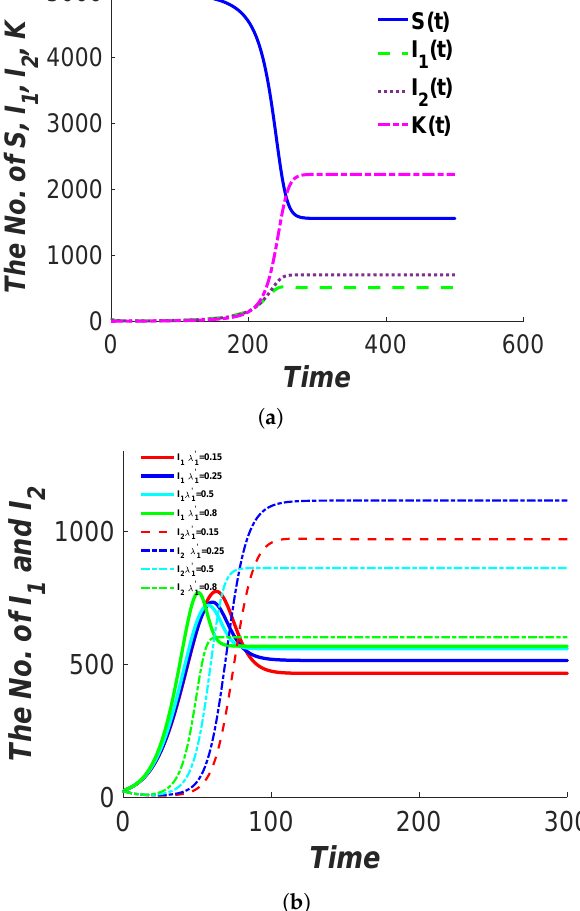
Figure 7. The evolution of the number of [ S ] , I 1 , I 2 over time for the co-infection case. ( a ) R 0 < 1 = 0.7, λ (cid:48) = 0.8, and restraint condition satisfied: λ 1 = 0.25, λ 2 = 0.15, γ 1 = 0.6, γ 2 = 0.4, λ (cid:48) 2 1 = 0.3, γ (cid:48) = 0.6, γ = 0.1. ( b ) R > 1 with various values of the super-spreading parameter gamma (cid:48) 3 0 2 1 = 0.25, γ (cid:48) = 0.65, γ (cid:48) = 0.6, γ = λ (cid:48) : λ 1 = 0.35, λ 2 = 0.25, γ 1 = 0.6, γ 2 = 0.4, λ (cid:48) 3 2 2 1 1